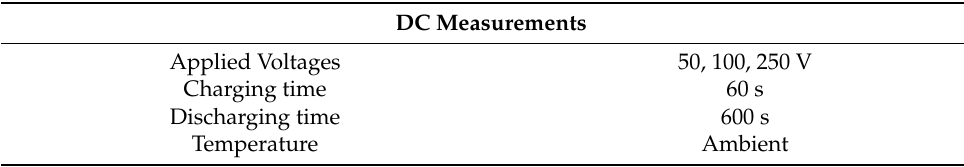
Table 5. DC measurements’